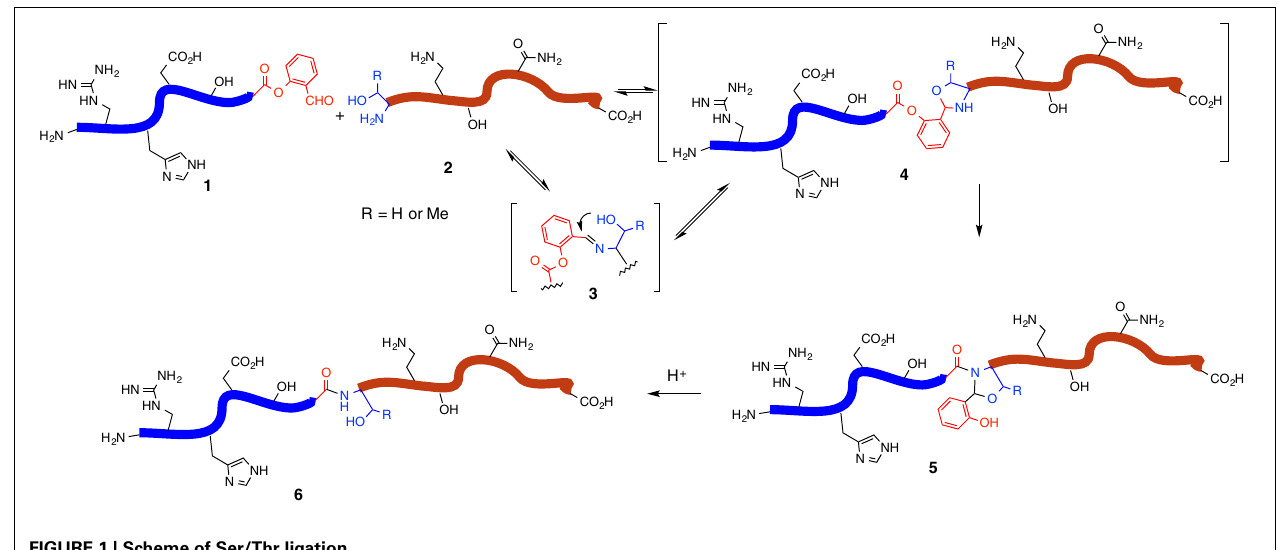
FIGURE 1 | Scheme of Ser/Thr